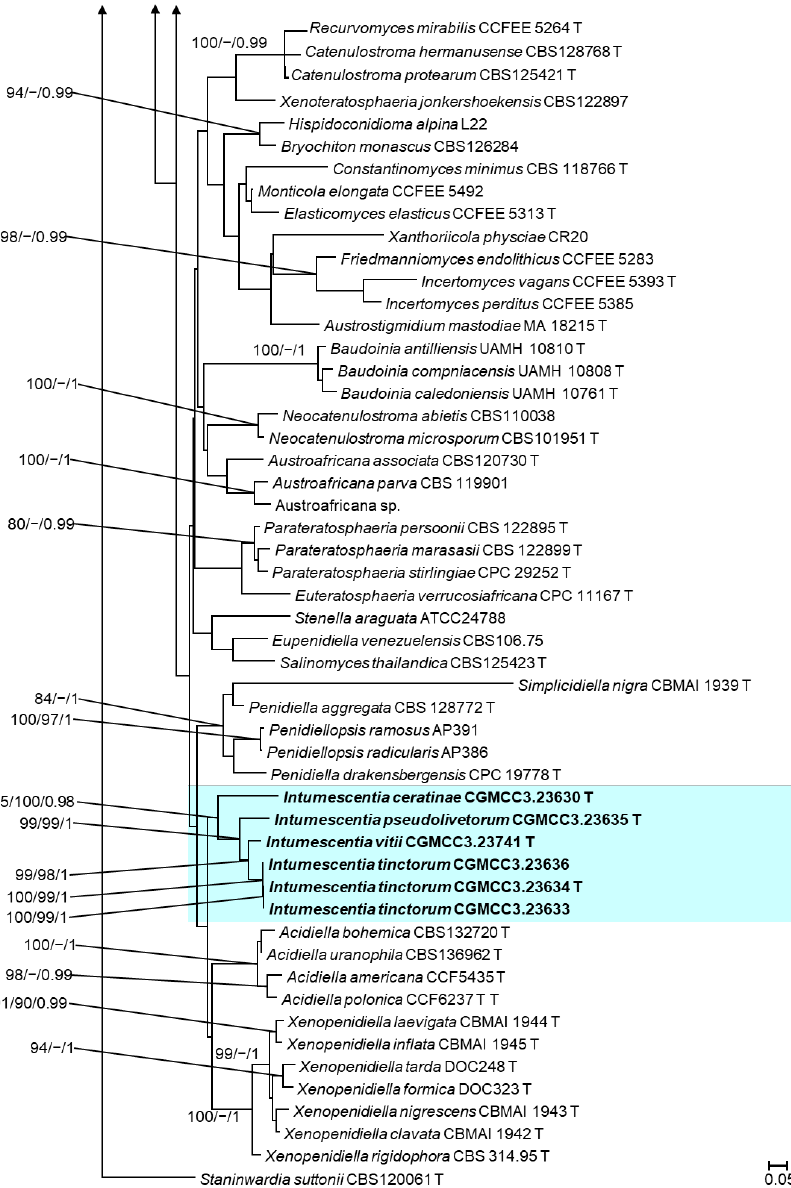
Figure 3. Maximum likelihood phylogeny using the concatenated dataset (LSU+ITS+ACT+ CAL+RPB2+TEF1) for Teratosphaeriaceae. The bootstrap support value ≥75% and posterior probability ≥ 0.95 displayed above the node are ML/MP/PP. The isolates of Intumescentia gen. nov. obtained in this study are shown in bold and highlighted in blue. T = ex-type isolates.